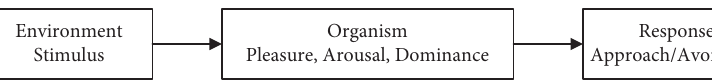
Figure 1: Framework of the SOR model